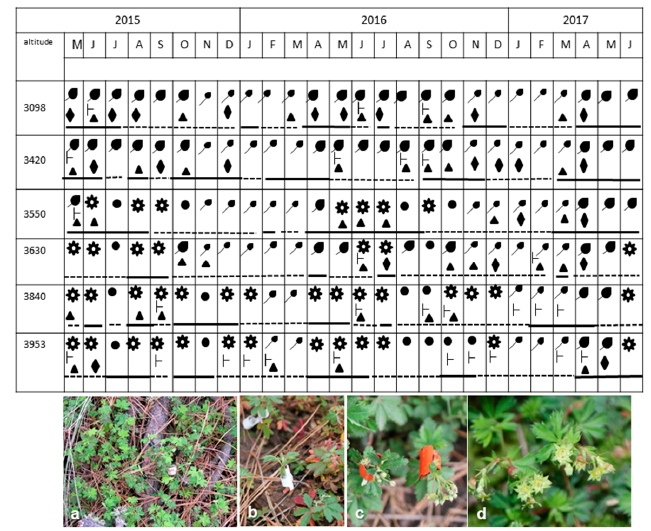
Figure 1. Phenology and cambial activity of Alchemilla procumbens over the altitudinal gradient, Sierra